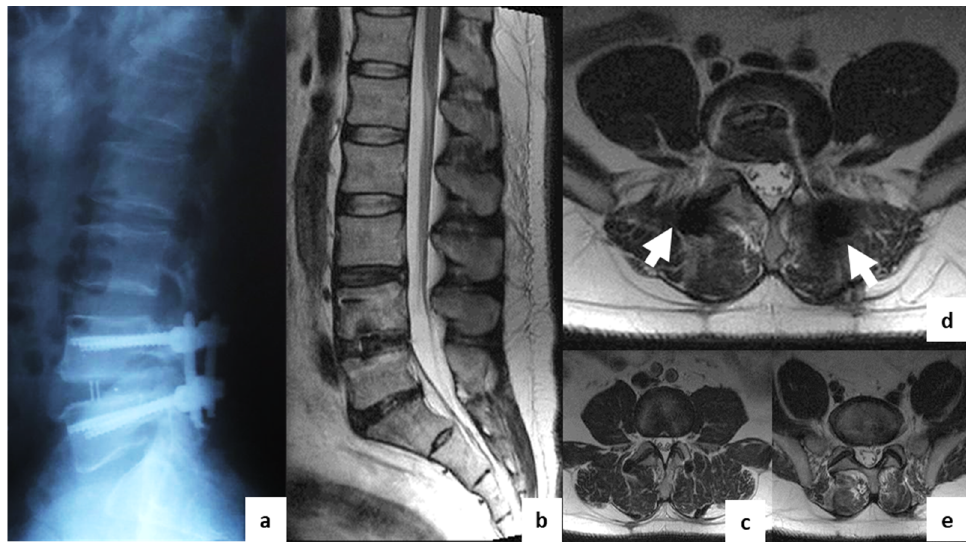
Figure 5. Postoperative T2w MRI of a 43-year-old male from group IIc with degenerative disc disease at L4–L5. ( a )—sagittal X-ray; ( b )—sagittal MRI; ( c )—axial MRI at L3–L4 (overlying segment); ( d )—axial MRI at L4–L5 (operation level); ( e )—axial MRI at L5–S1 (underlying segment). The white arrows indicate regions with visible artifacts.